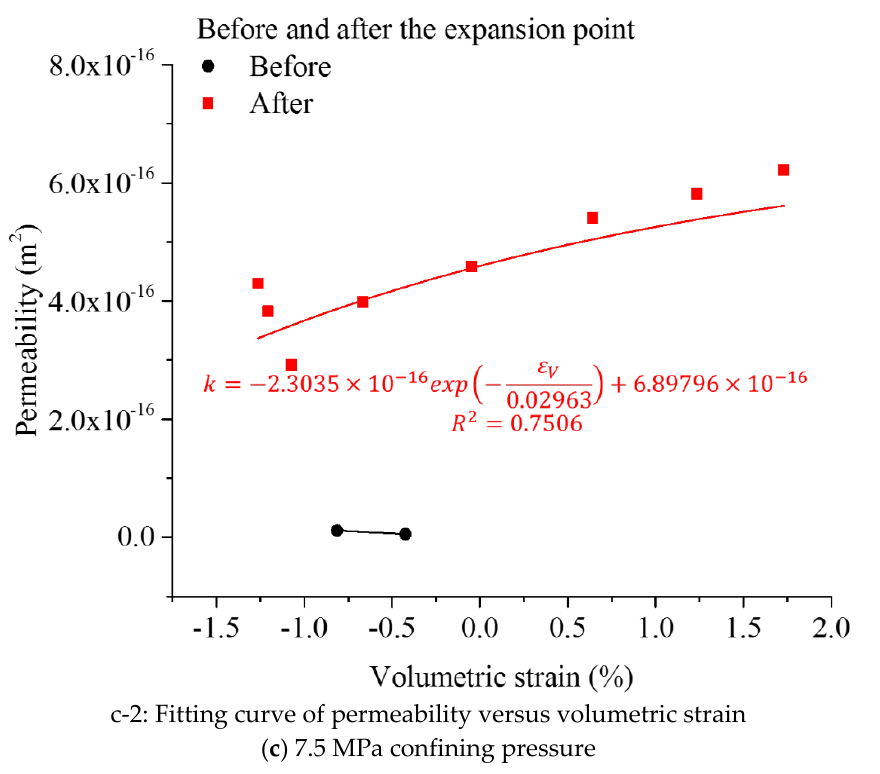
Figure 19. Permeability and strain evolution of coal sample C1 versus differential stress (numerical simulation results).